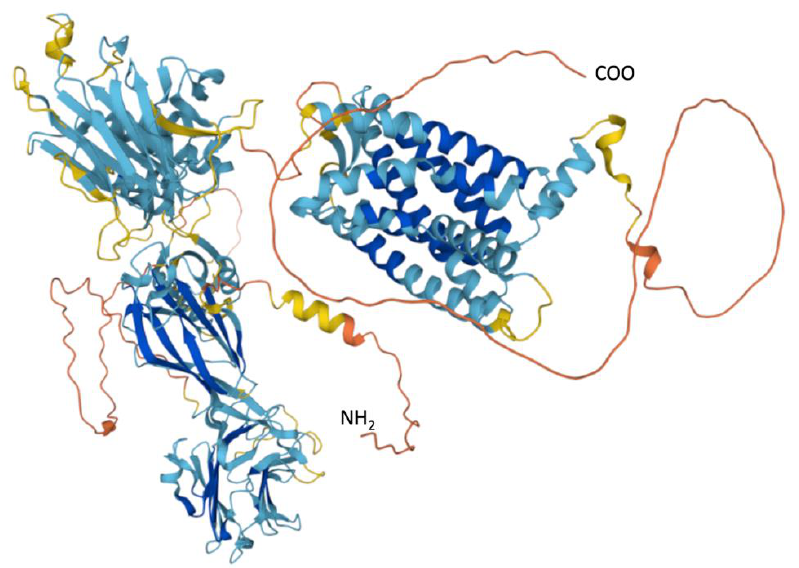
Figure 4. Adhesion G-protein coupled receptor G6. From https://www.uniprot.org/uniprot/Q86SQ4